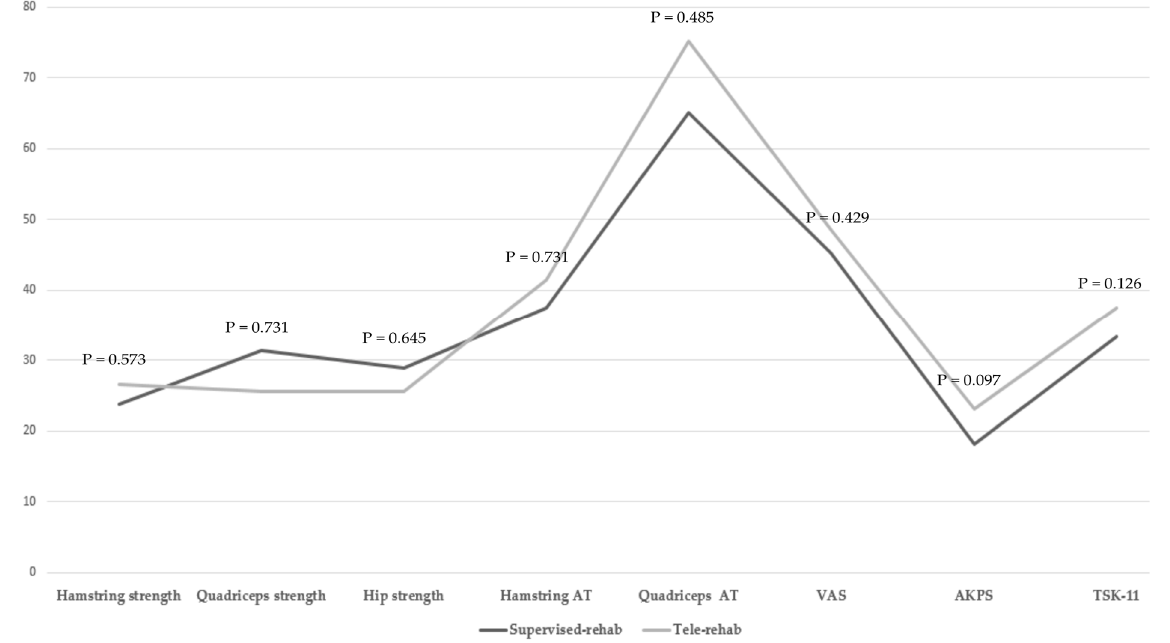
Figure 2. Comparison of the rate of change in muscle strength, muscle activation time, and patient- reported outcomes between the supervised rehabilitation group and telerehabilitation group.